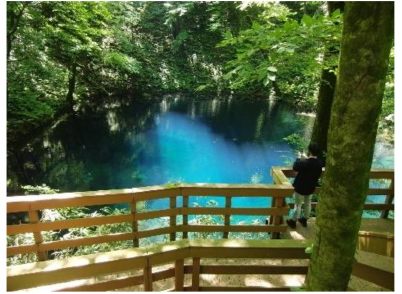
Figure 1. Ao-ike Pond at 10:20 (JST), 5 June